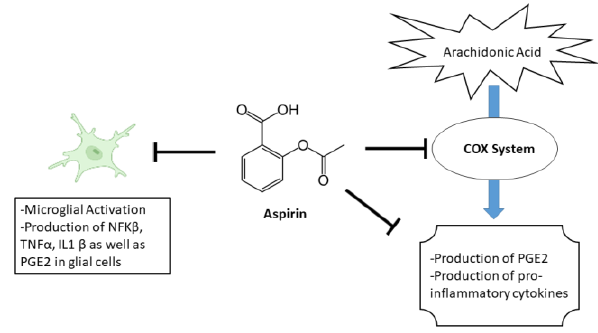
Figure 1. Illustration of aspirin’s